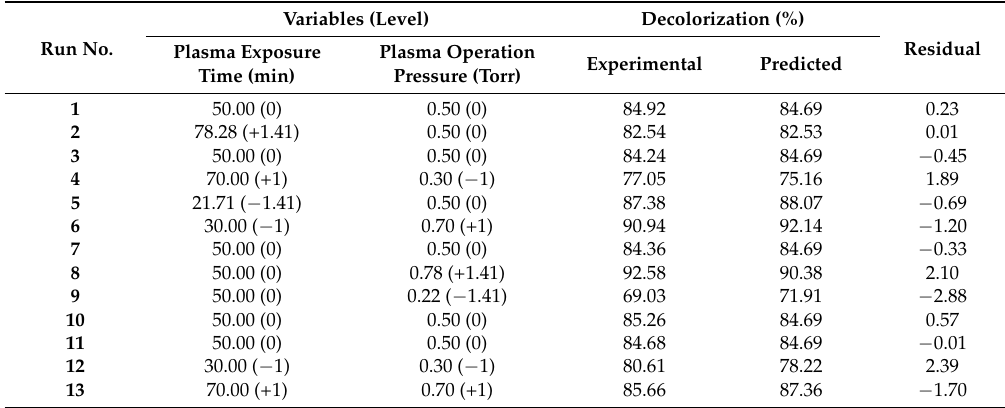
Table 2. Experimental and predicted response values for the central composite design. The values in brackets are codified